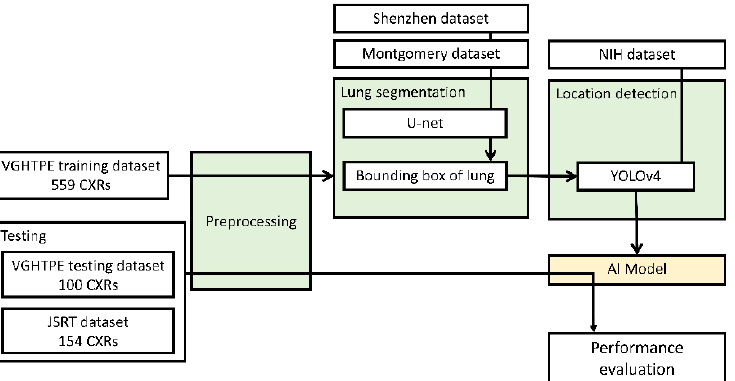
Figure 1. Pipeline of the study design.